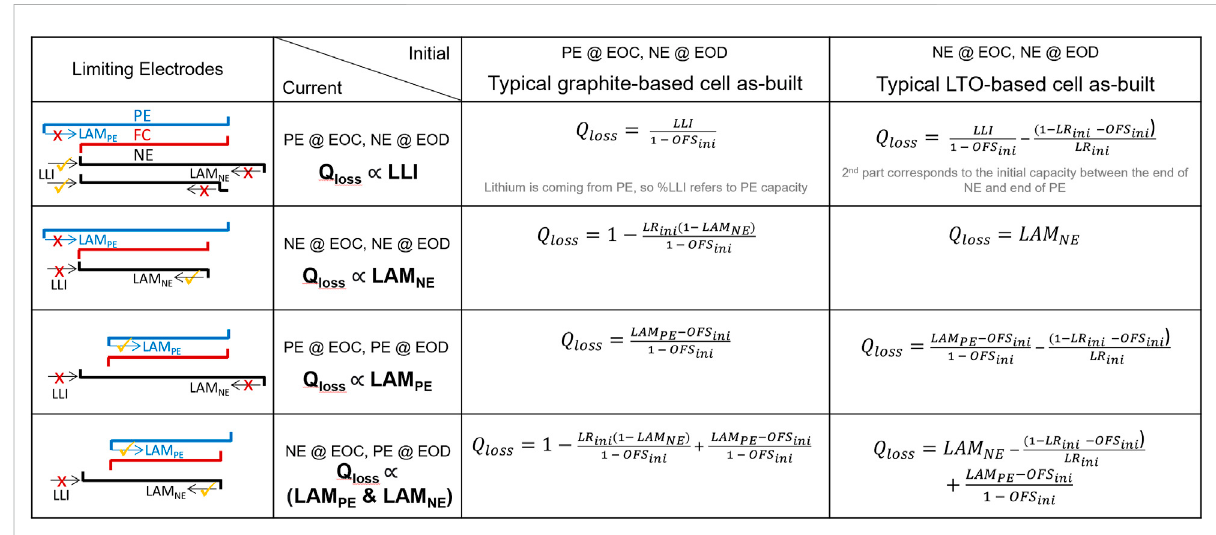
FIGURE 6 Impact of limiting electrodes on the main contributor to capacity loss with associated equations for typical graphite and LTO-based cells.